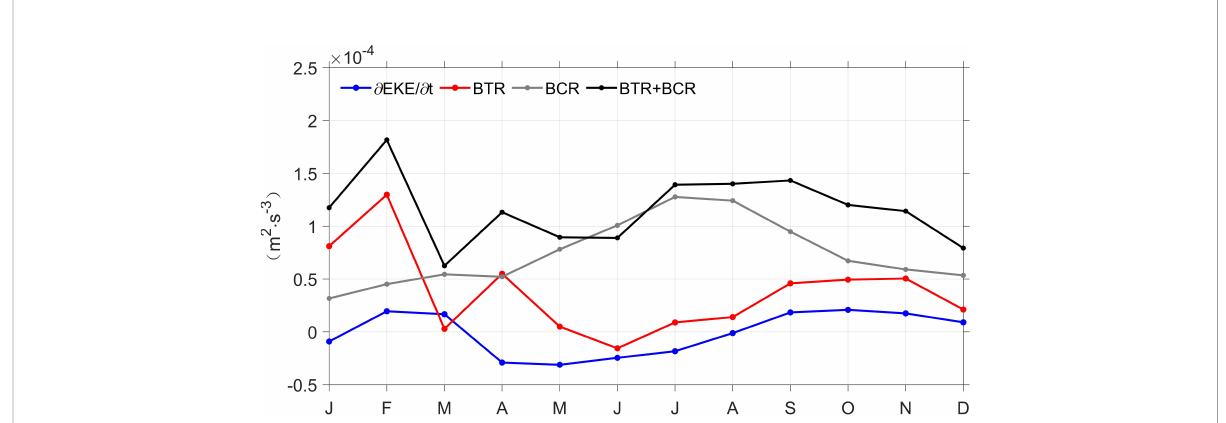
FIGURE 8 Seasonal variations of mean EKE trend (blue line), BTR (red line), BCR (gray line), and BTR+BCR (black line) averaged over the upper 300 m layer from OFES during July 1999-October 2009 in the EAC region (148°E-160°E,